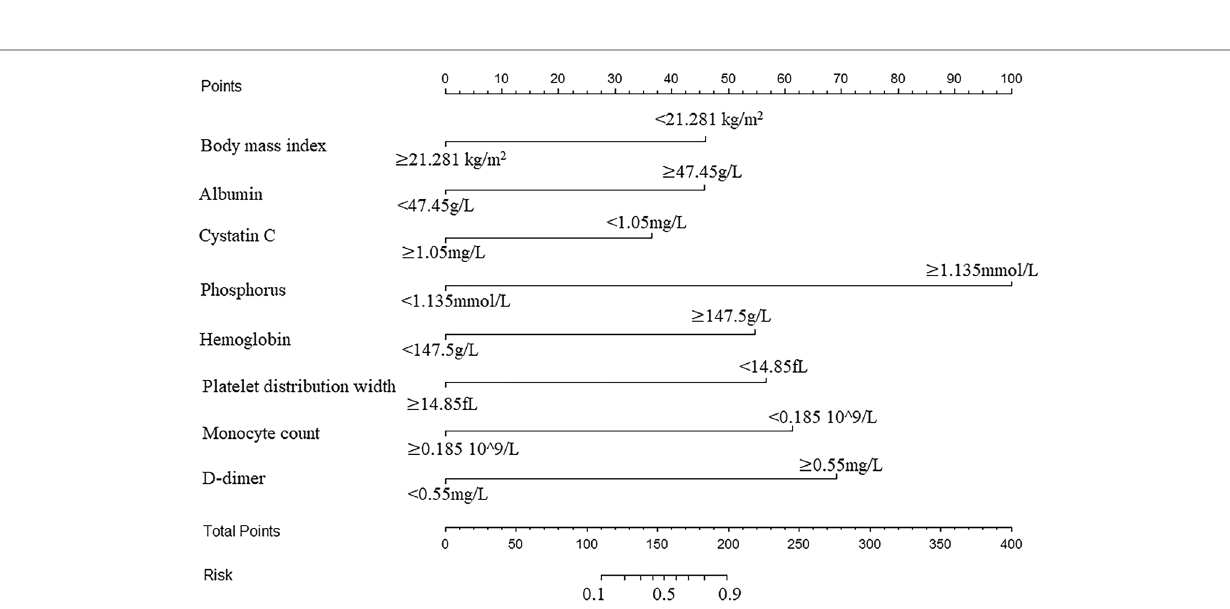
For breast cancer patients in China, one study found that ER, axillary pCR. The C index of the model training group and validation group were 0.834 and 0.756 respectively (10). Guo